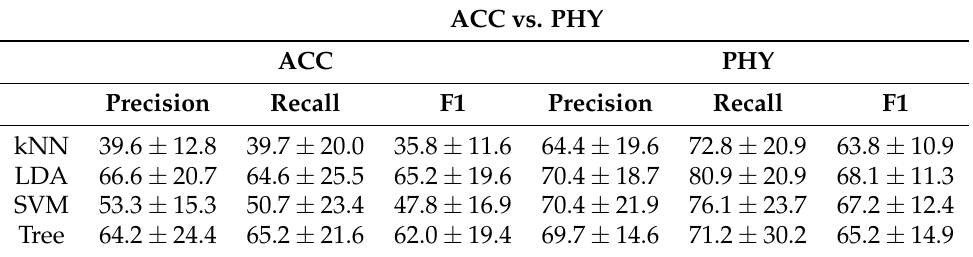
Table A1. Precision, Recall and F1 scores of the ACC vs. PHY classification problem.